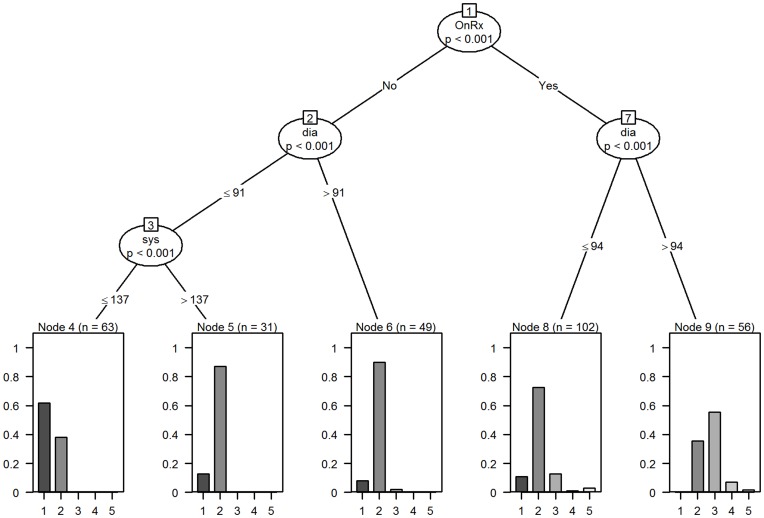
Tree model for decisions made at subsequent visit for all vignettes.Terminal nodes have proportion on the y-axis and decision code (1 to 5) on the x-axis. OnRx stands for on treatment. Sys is systolic BP and dia is diastolic BP.